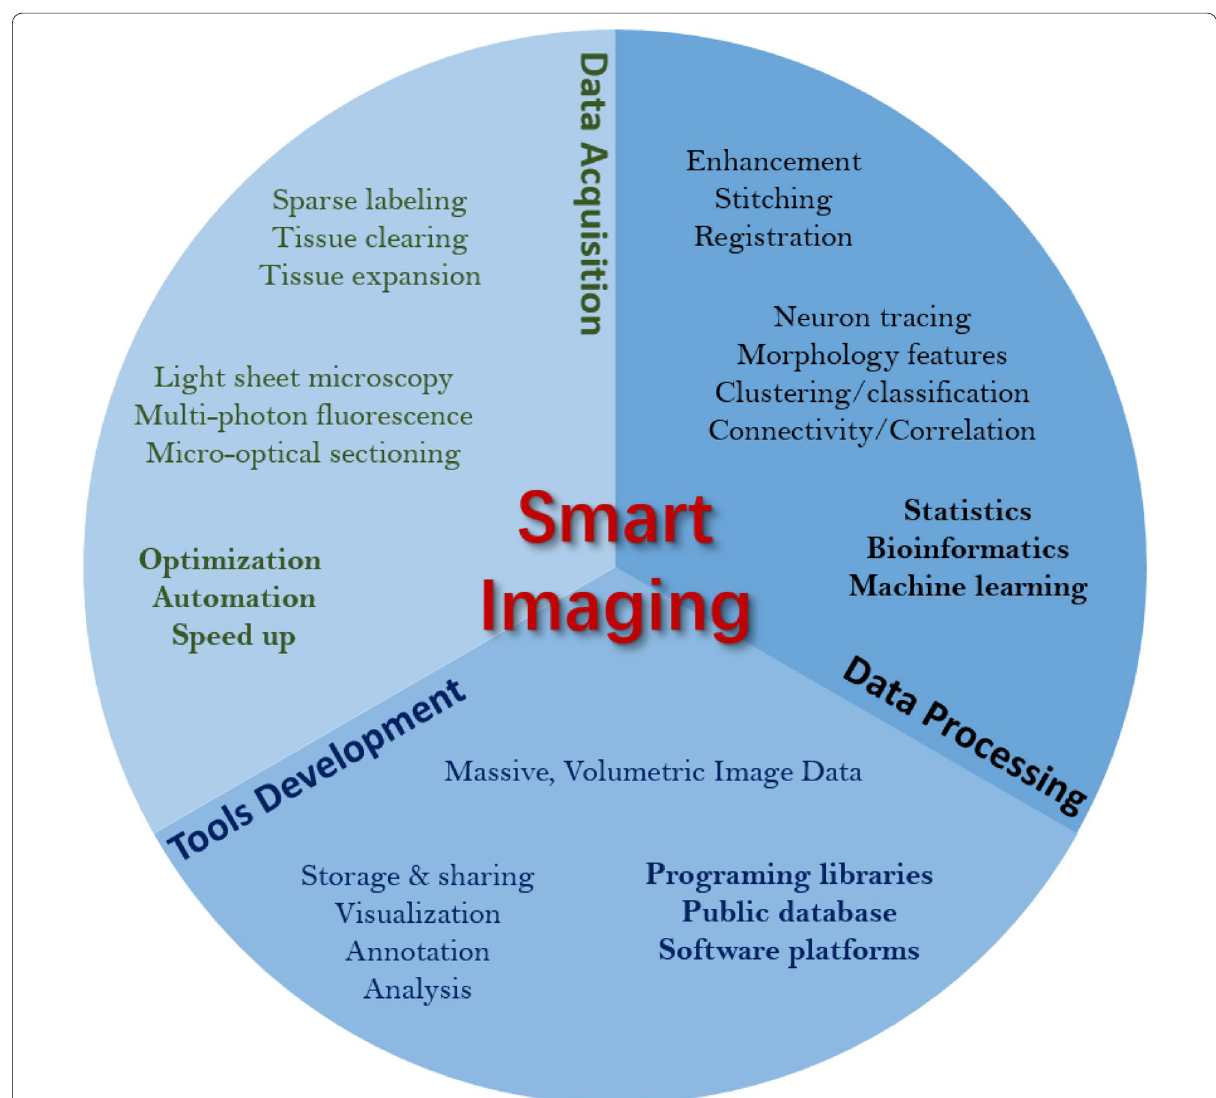
Fig. 1 Key components to build up a smart imaging system in brain-wide neuroscience at single-cell